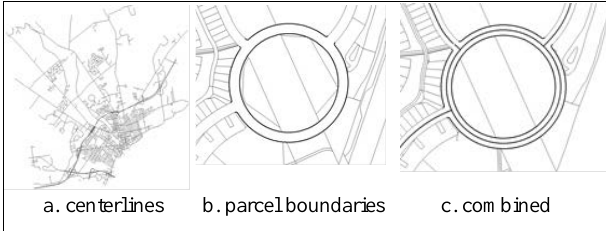
Figure 4. Road networks expressed differently Data Sources: City of Bangor and Los Angeles County, USA Figure 4.b illustrates a complex “roundabout” pattern consisting of circular sections formed by dual lines. It is desirable for the